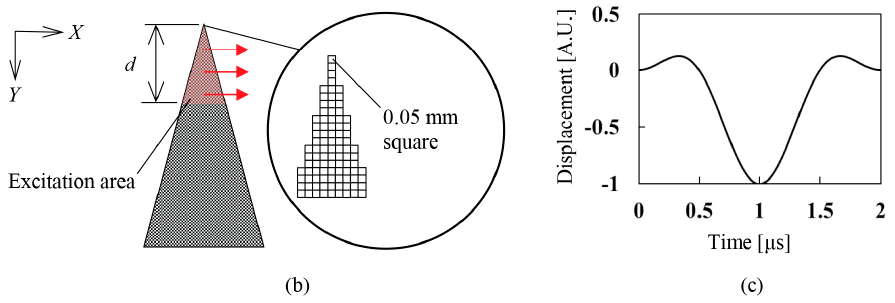
Figure 2. Schematic diagrams of simulation model. ( a ) Waveguide rod with sharp wedge attached to the water. ( b ) Excitation area at the front surface of the waveguide rod and finite element meshes near the tip of the waveguide rod. ( c ) Input waveform for excitation of wedge wave at the front